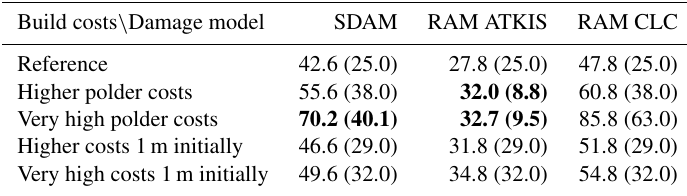
Table 9. Life-time costs + risks (in brackets: life-time costs only) [MEUR] associated with the optimal protection